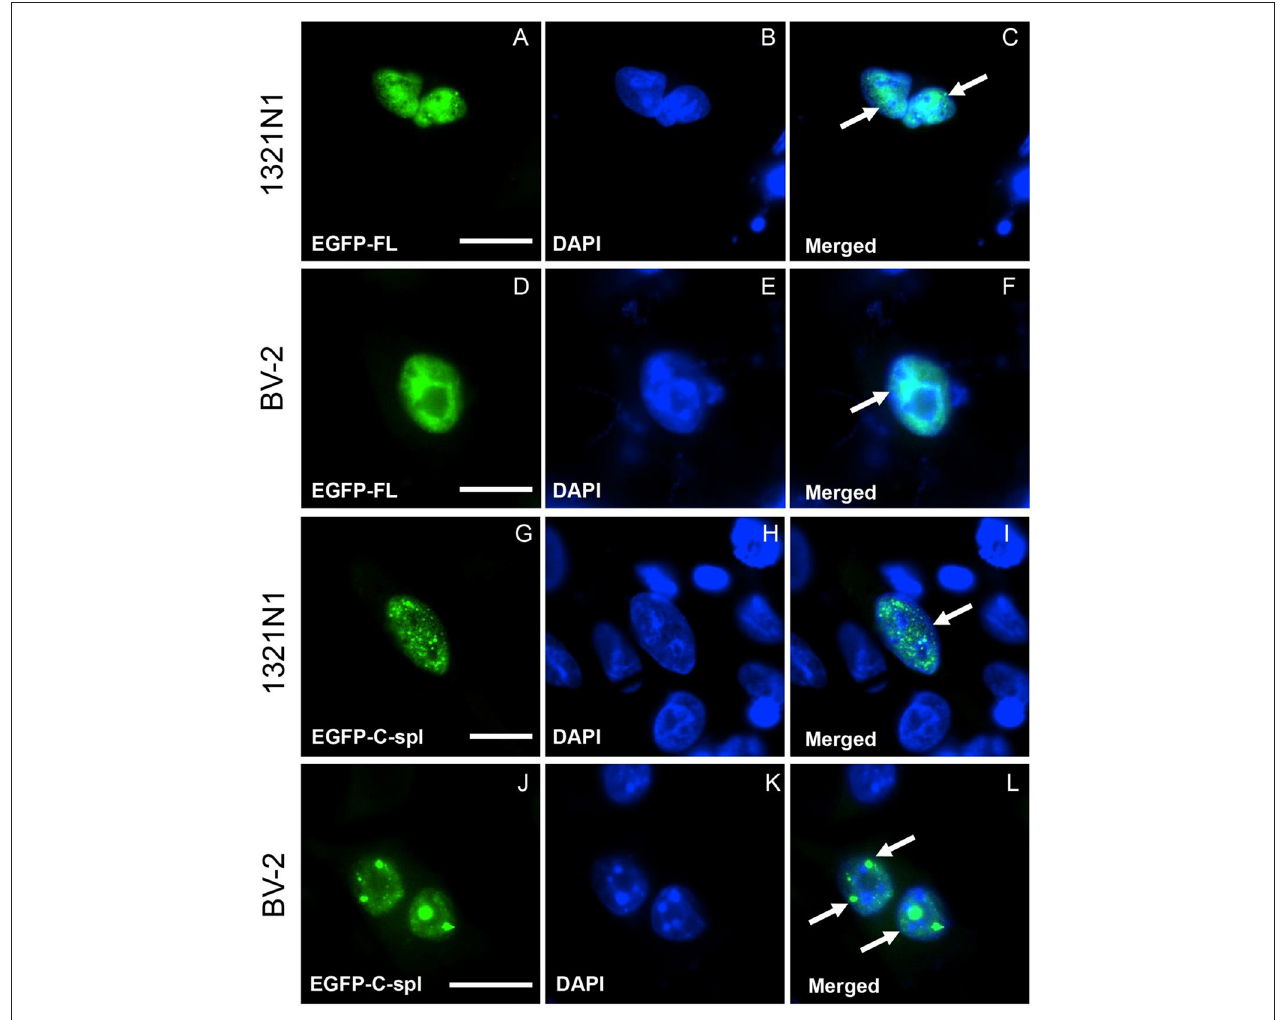
FIGURE 3 | Subcellular localization of TDP43-FL and TDP43C-spl in non-neuronal cells. 1321N1 cells (astrocytoma cell line) and BV-2 cells (microglial cell line) were transfected with EGFP-tagged TDP43-FL (A–F) or EGFP-tagged TDP43C-spl (G–L) . The EGFP-tagged TDP43-FL (A,D) and blue DAPI- nuclear stain (B,E) were co-localized, both in 1321N1 cells [arrows in (C) ] and BV2 cells [arrow in (F) ]. EGFP-tagged TDP43C-spl (G,J) and DAPI-staining (H,K) were also co-localized to the nucleus in 1321N1 cells [arrow in (I) ] and BV2 cells [arrows in (L) ]. Note that TDP43-FL appears diffusely within nuclei, whereas TDP43C-spl forms speckles [indicated by arrows in (I,L) ]. Scale bars = 15 µ